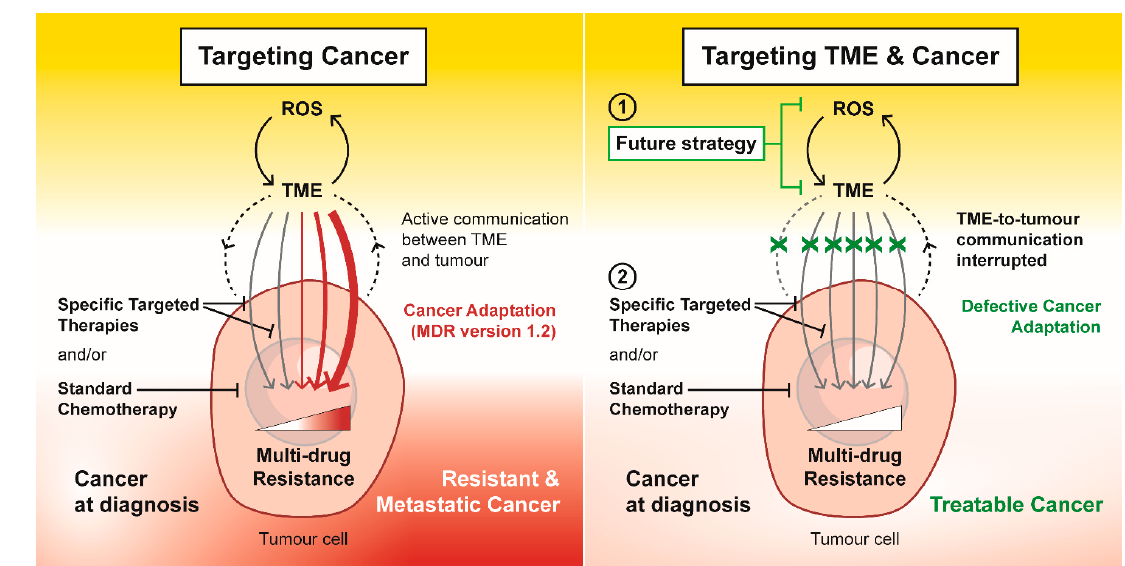
Figure 3. Targeting tumour microenvironment (TME) as a future strategy to overcome multi-drug resistance. In response to specific targeted therapies and standard chemotherapeutics, external and internal stress within the TME drives and promotes cancer adaptation in the form of drug resistance and metastasis. Targeting the ROS-TME circuit interrupts the TME-to-tumour communication that maintains a multi-drug resistance phenotype. This future strategy to target TME has the potential to disrupt the cancer adaption response, which could re-instate the efficacy of specific targeted therapies and standard chemotherapeutics in an attempt to treat cancer successfully.